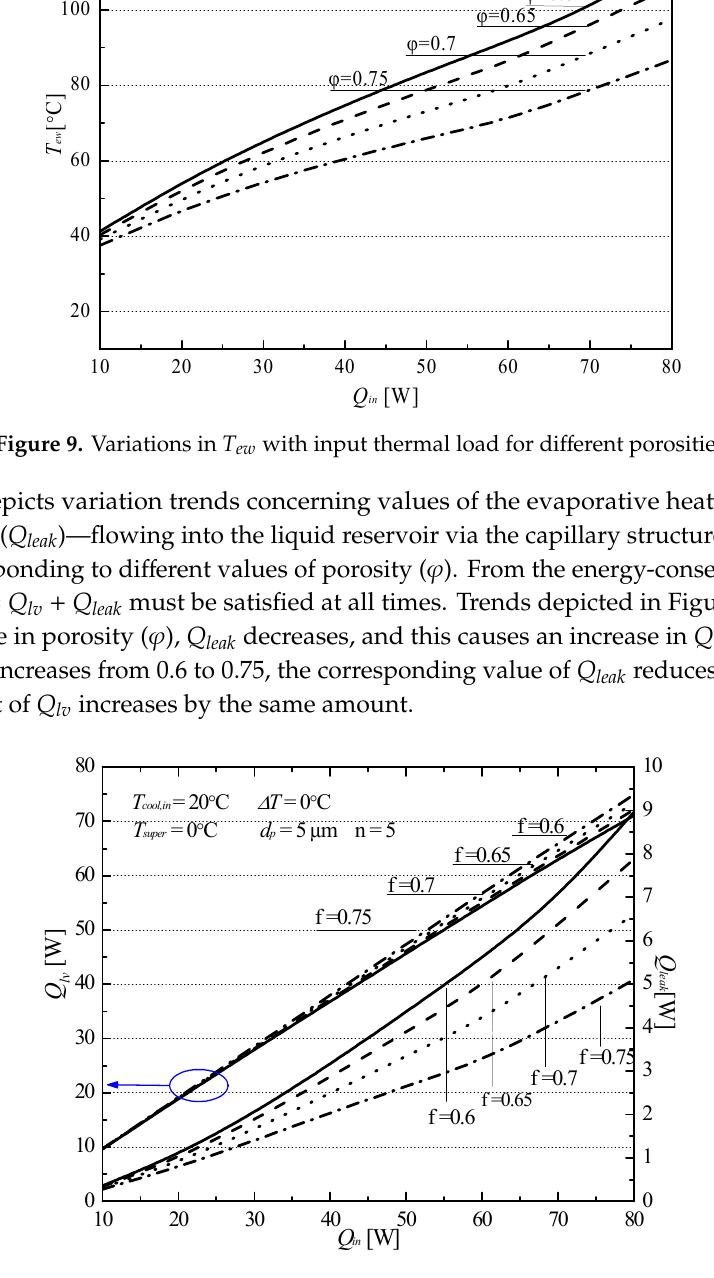
Figure 11. Variations in T r and T co with input thermal load for different porosities. Figure 12 depicts variation trends concerning values of the LHP evaporation- and condensation-interface temperatures ( T lv and T vl , respectively), at different values of the porosity, as a function of Q in . As can be seen in the figure, an increase in φ corresponds to reduction in the values of both T lv and T vl . As described in Equations (18) and (22), the evaporator-vapor temperature reduces with increase in φ , thereby causing T lv to decrease. In addition, as described in Equation (22), increase in φ causes a reduction in the interface area ratio ( A lv / A vl ), which in turn, reduces T vl . At Q in =